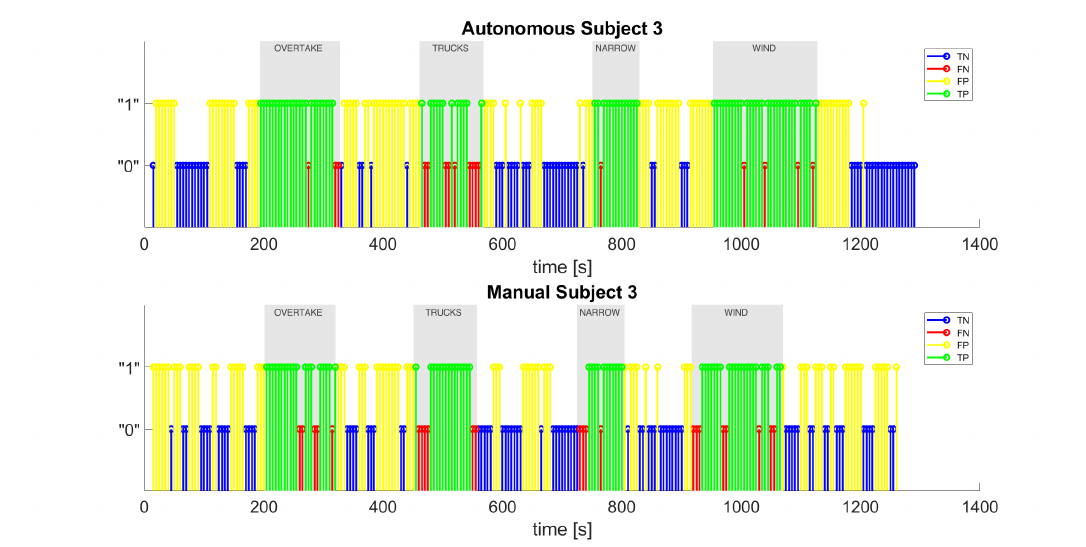
Figure 13. The classifier’s output for test subject 3 in autonomous and manual